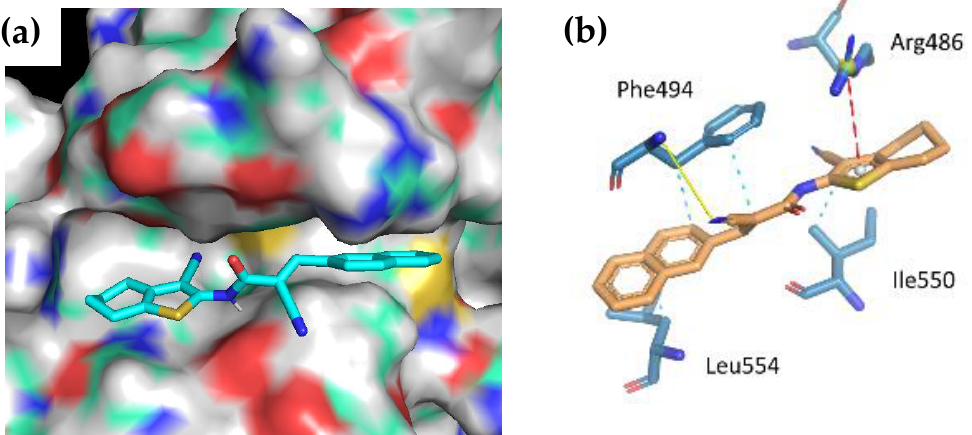
Figure 7. Position of compound 36b in the allosteric site of telomerase as predicted by molecular docking. ( a ) Structure of telomerase presented as molecular surface. ( b ) The main interaction of compound 36b with allosteric site. The H-bond is represented by the yellow line, π -cation interaction by the red dashed line, and hydrophobic interaction by the cyan dashed lines.